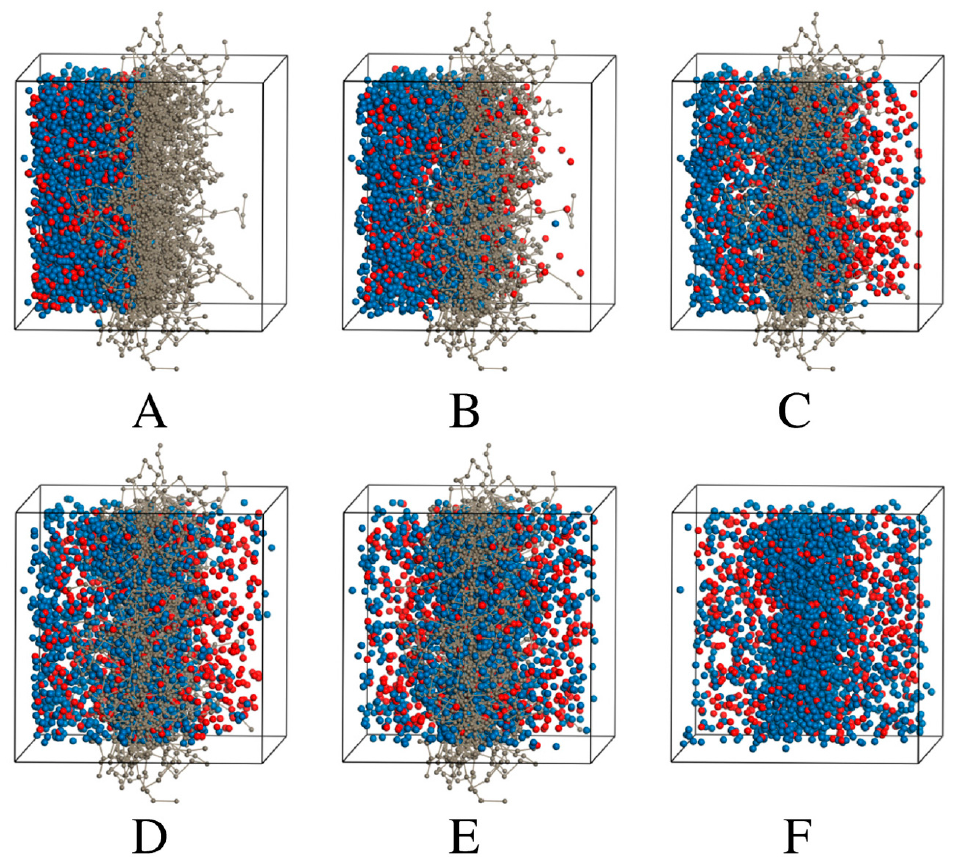
Figure 3. A simulation box of 1:4 charged:neutral drug beads. Nitrocellulose (grey), neutral salicylic acid (blue), charged salicylate (red). Only nitrocellulose, neutral and charged drug beads are shown at different multiples of τ during the trajectory simulation; ( A ) 1 τ , ( B ) 25,000 τ , ( C ) 187,000 τ , ( D ) 250,000 τ , ( E ) 500,000 τ and ( F ) 1,000,000 τ (nitrocellulose is not shown).